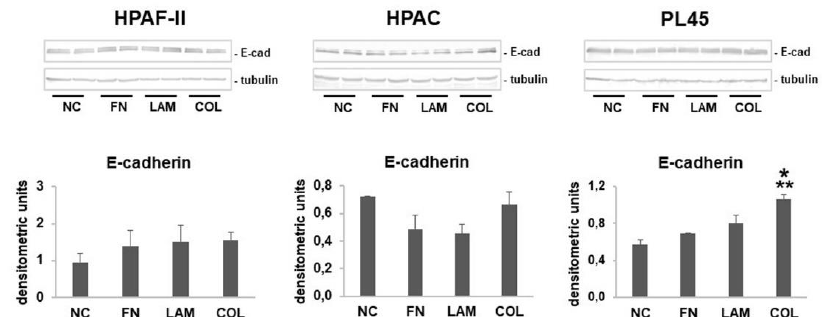
Figure 3. E-cadherin protein levels. Representative Western blot analysis and bar graphs showing E-cadherin expression in whole cell lysates of HPAF-II, HPAC, and PL45 cells cultured on FN, LAM, COL, or without coating (NC). Data are means ± SD. * p < 0.01 vs. NC; ** p < 0.05 vs. FN, LAM.